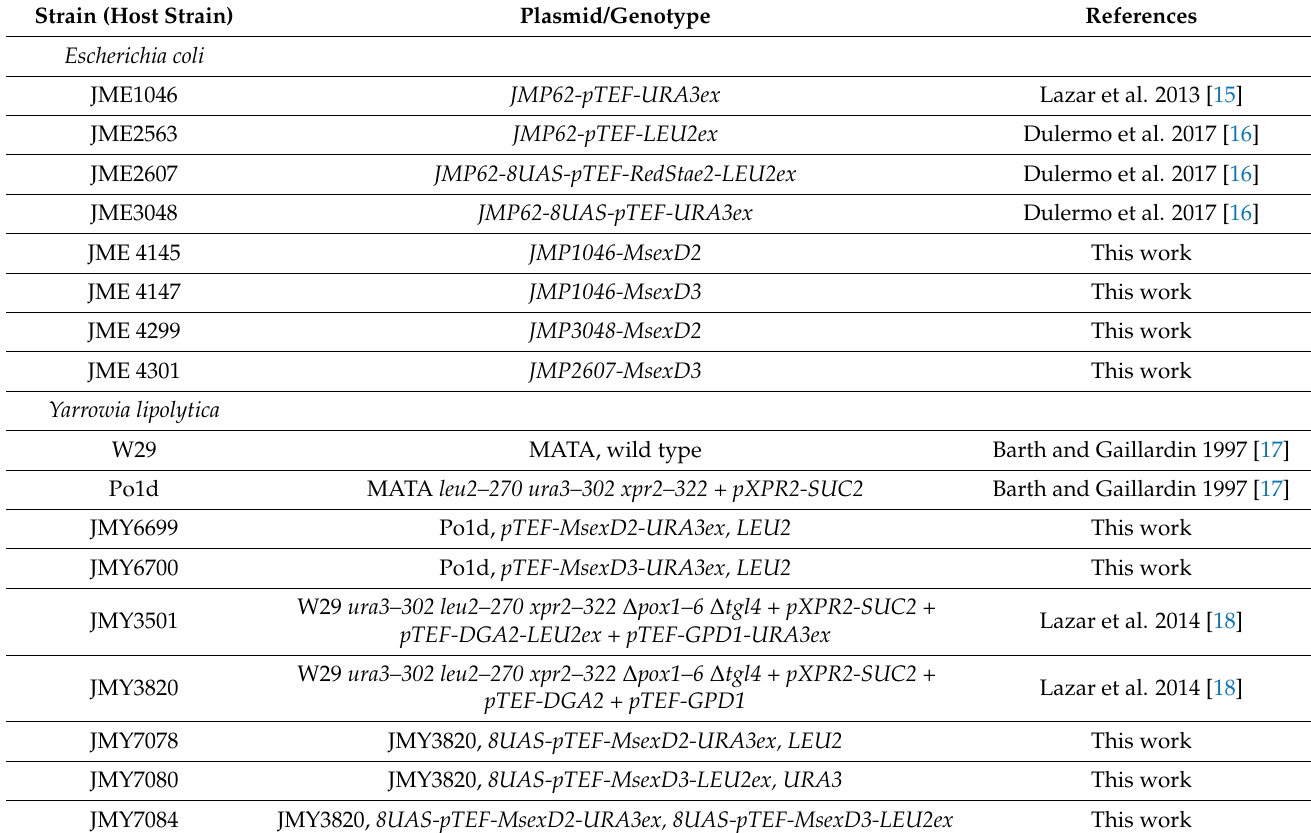
Table 1. Microorganisms and plasmids used in the